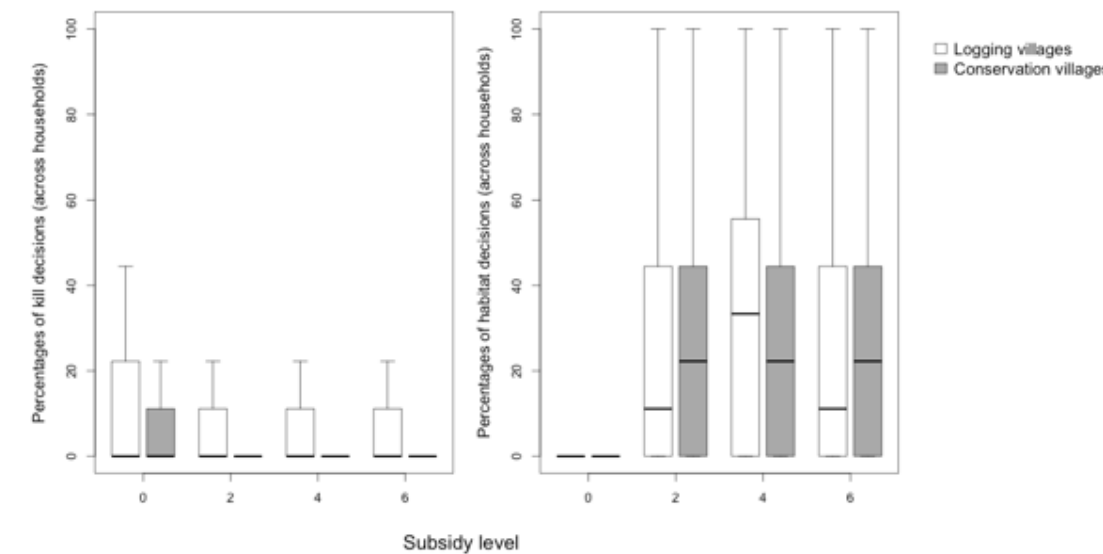
Figure A1.3: Distribution of observed percentages of decisions to kill and to provide habitats per subsidy level across households and groups. Solid black bars represent the median proportion, boxes the interquartile range and error bars extend to 1.5 times the IQR limits.